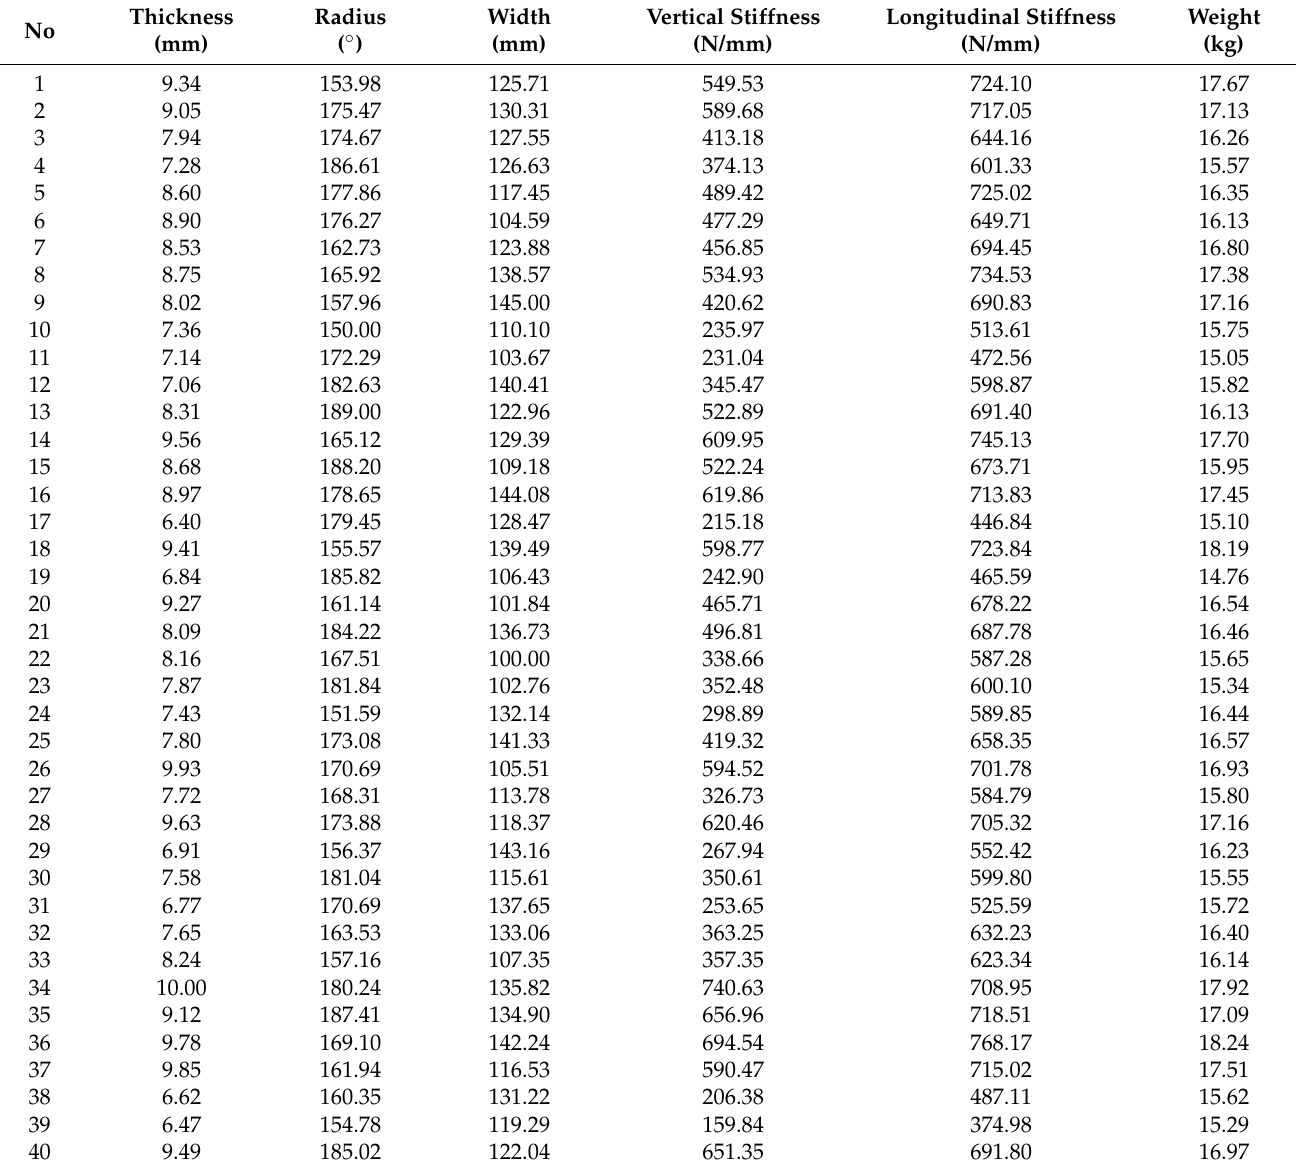
Table 4. Design of experiments using Latin hypercube